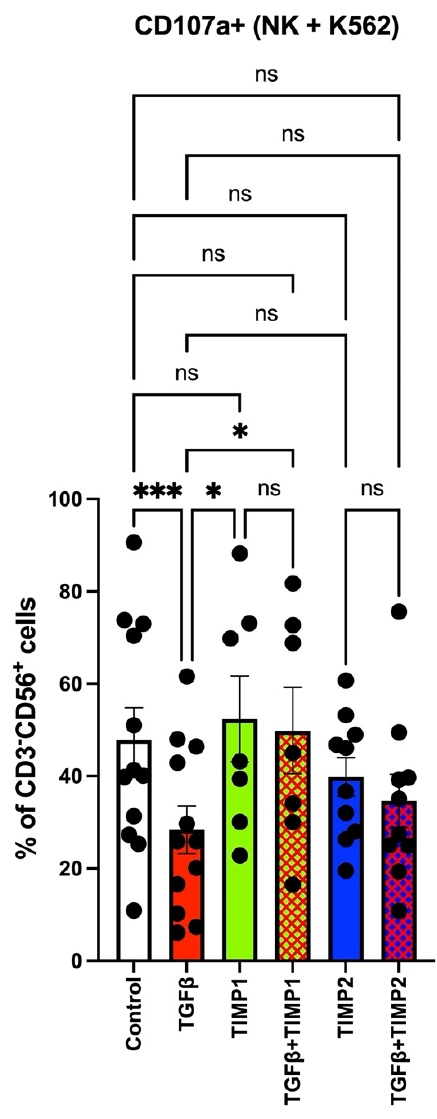
Figure 4. Effects of TIMPs on degranulation capabilities in TGF β -induced decidual-like NK cells. TIMP-1 was significantly different from TGF β , and TIMP-1 when combined TGF β was able to counteract TGF β . TIMP-2 did not have a significant ability to revert the impaired degranulation capabilities when combined with TGF β . The graph shows the specific degranulation in the co-culture system with subtracted basal CD107a levels (in NK cells alone/in absence of cell target). Results are shown as mean ± SEM, ANOVA, ns = not signficant; * p < 0.05; *** p < 0.005. PBMCs from 7–12 different healthy donors were used. Controls were cells in RPMI medium alone.